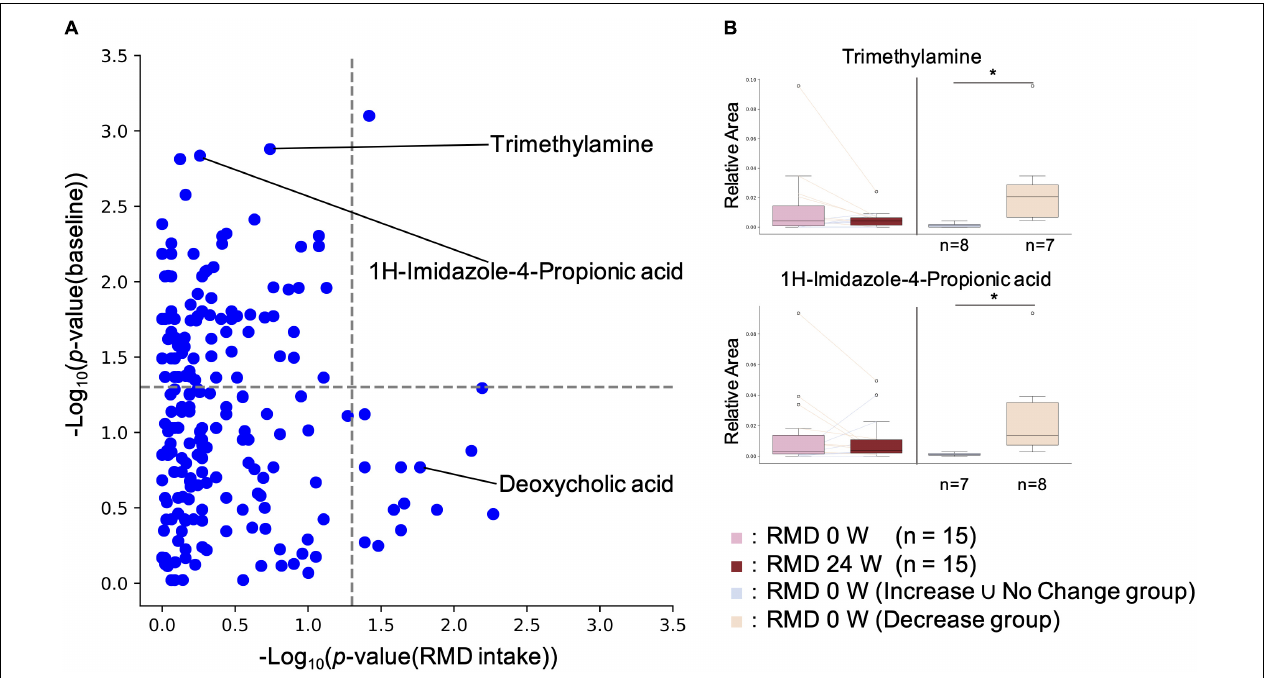
FIGURE 4 | Effect of RMD intake on intestinal metabolite concentrations depends on the individual’s intestinal metabolite concentration at the baseline. (A) X axis indicates the p -value of the Wilcoxon signed-rank test for each metabolite between RMD 0 week and RMD 24 weeks groups. Y axis indicates the P -value of the Wilcoxon rank sum test for each metabolite between the two groups, increased and decreased groups after RMD intake, at the baseline. If the subjects with increased amounts of each metabolite were more than the subjects with decreased amounts of each metabolite after RMD intake, then Increase group and Decrease ∪ No Change group were compared by the Mann-Whitney U test; if the subjects with decreased amounts of each metabolite were more than the subjects with increased amounts of each metabolite, then Decrease group and Increase ∪ No Change group were compared by the Wilcoxon rank sum test. (B) Two representative metabolites are shown by boxplots. The left two boxes show the amount of the metabolite in RMD 0 week (left) and RMD 24 weeks (right) (* p < 0.05; the Wilcoxon signed-rank test), and the right two boxes show the amount of the metabolites at the baseline in RMD not decrease group, and RMD decrease group (* p < 0.05; the Mann-Whitney U